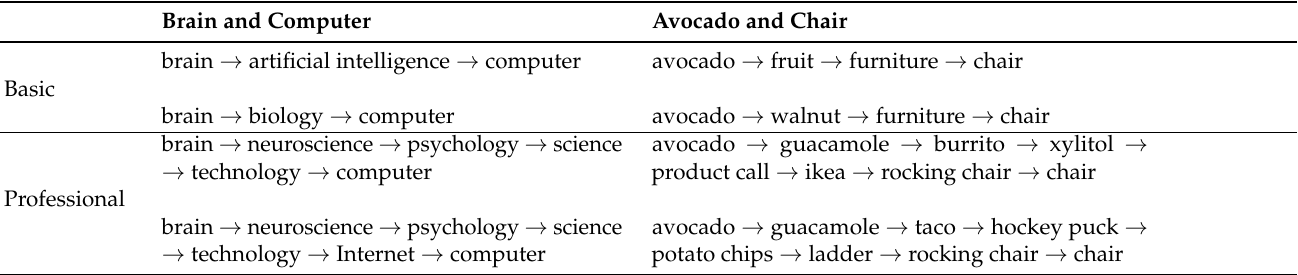
Table 8. The high-correlated two types of knowledge